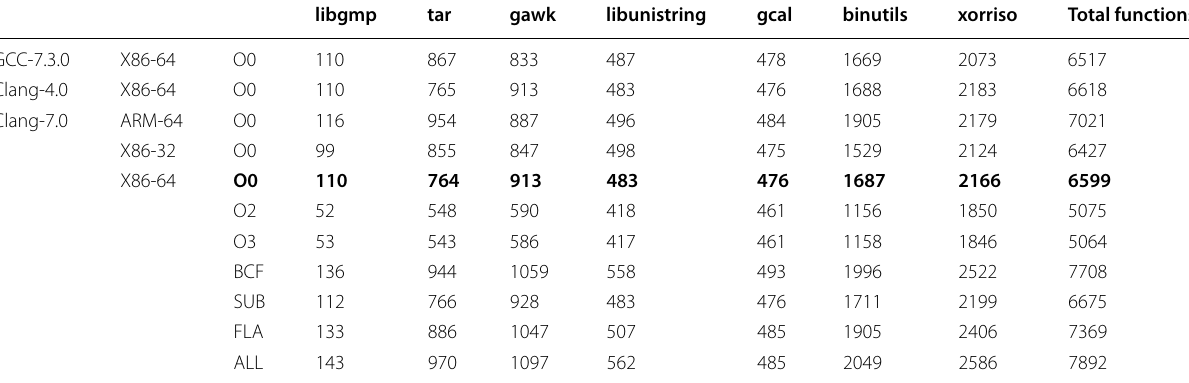
libgmp tar gawk